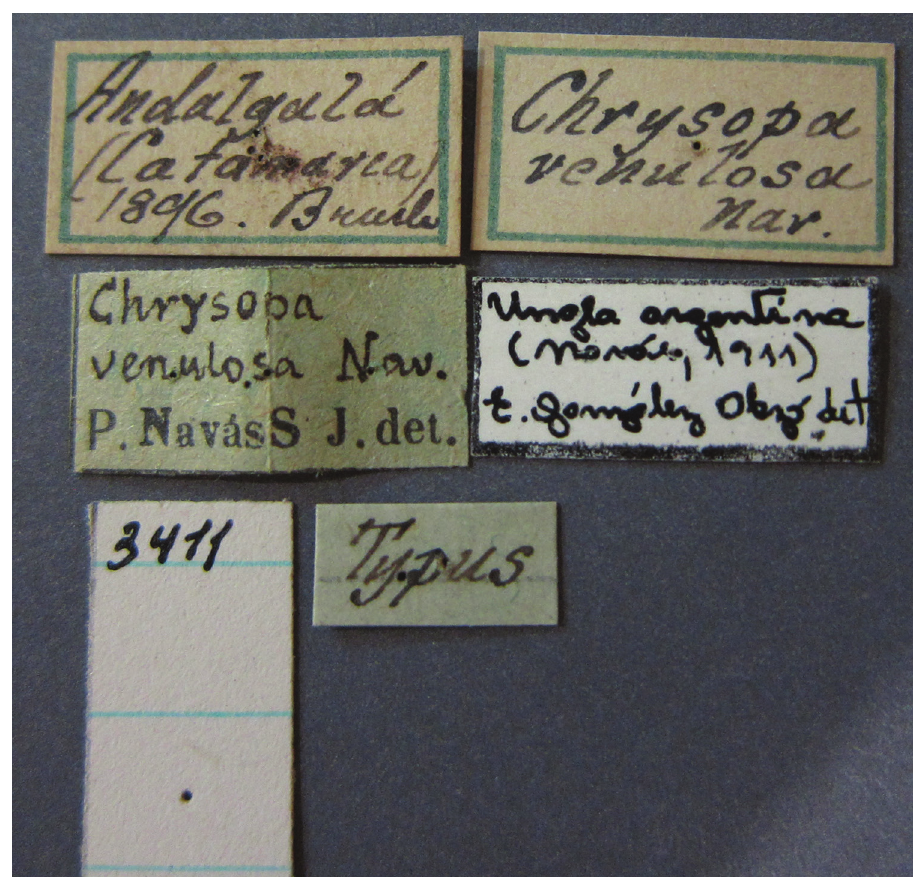
Figure 140. Chrysopa venulosa Navás: Labels from lectotype (Argentina, Catamarca, MLPA). similar to C. annulata (and C. nervulosa ) . We tend to agree with Adams, but without additional study, we cannot make a confident